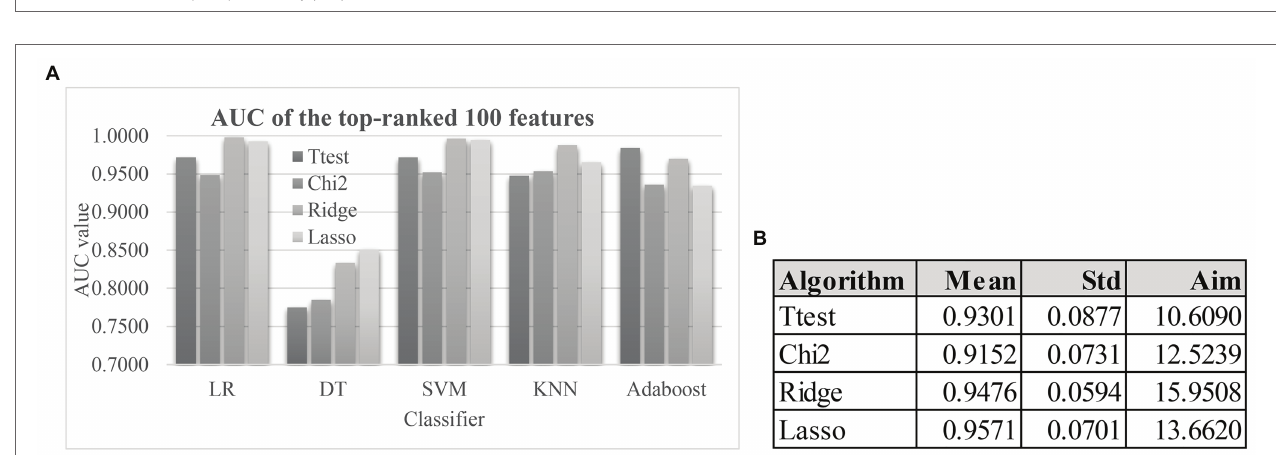
FIGURE 4 | The model performances and the weights of the four feature selection algorithms. (A) The AUC values of the top-100 features ranked by the four feature ranking algorithms using the five classification algorithms. Each of the four feature ranking algorithms Ttest, Chi2, Ridge, and Lasso selected the top-ranked 100 features. The AUC values of the feature lists were calculated by the stratified 5-fold cross validation (S5FCV) strategy of the five popular classification algorithms. (B) Calculation of the algorithm weight “Aim” for each of the four feature selection algorithms. The columns “Mean” and “Std” were the mean values and the SDs of the five classification algorithms. And the column “Aim” was defined as